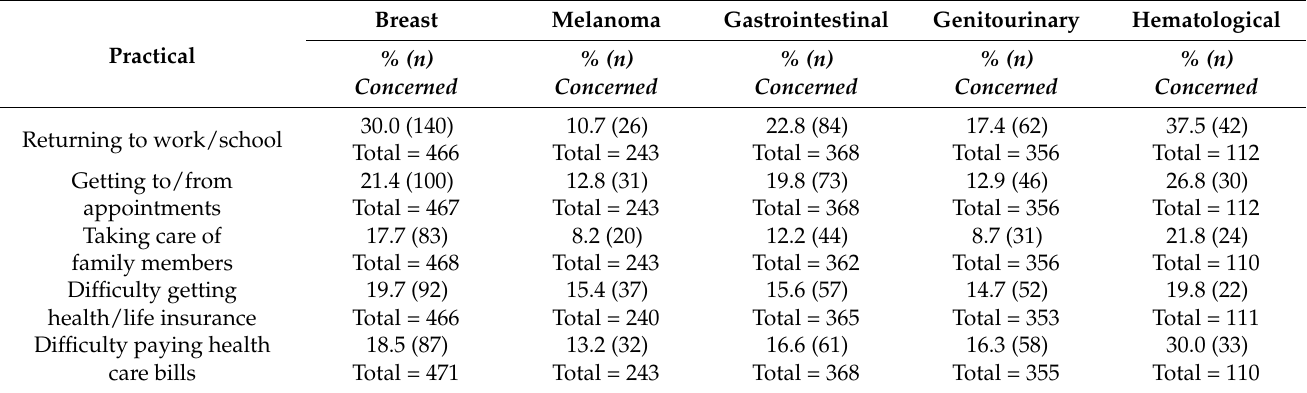
Table 5. Respondents’ concerns in the practical domain (by tumour group).